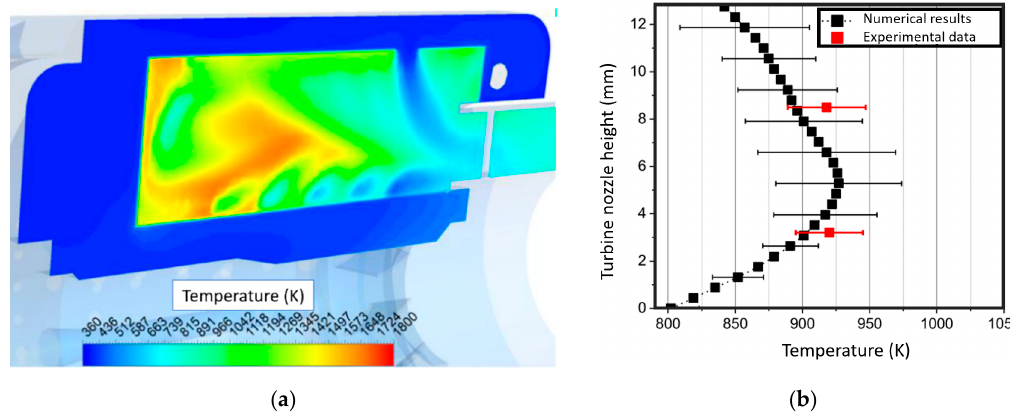
Figure 5. Turbine inlet temperature profile: ( a ) 3D numerical model visualization; ( b ) numerical and experimental data.